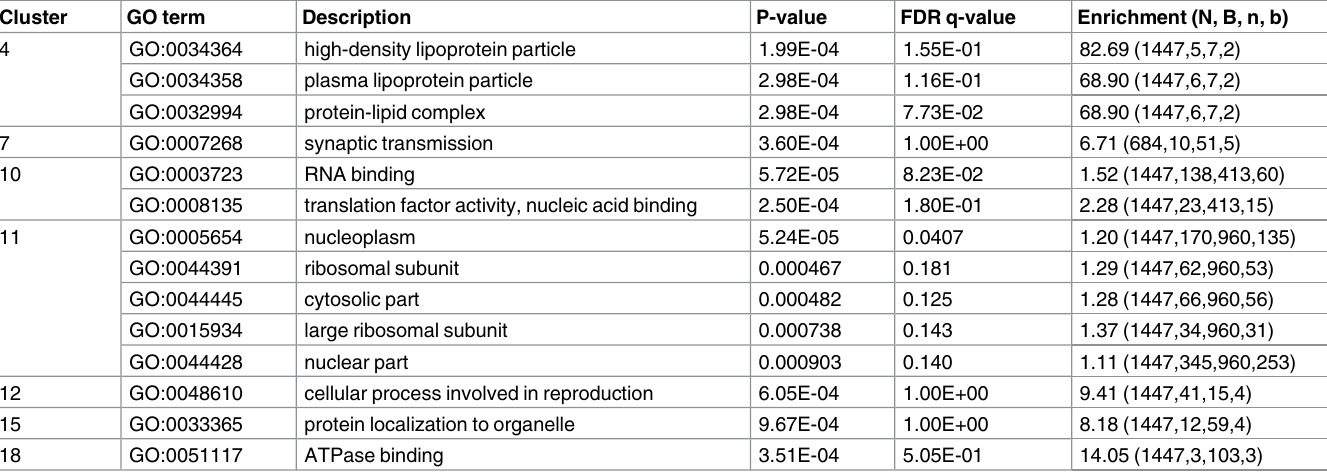
Table 1. The most significant Gene Ontology (GO) terms enriched in K-meansclustering. Cluster GO